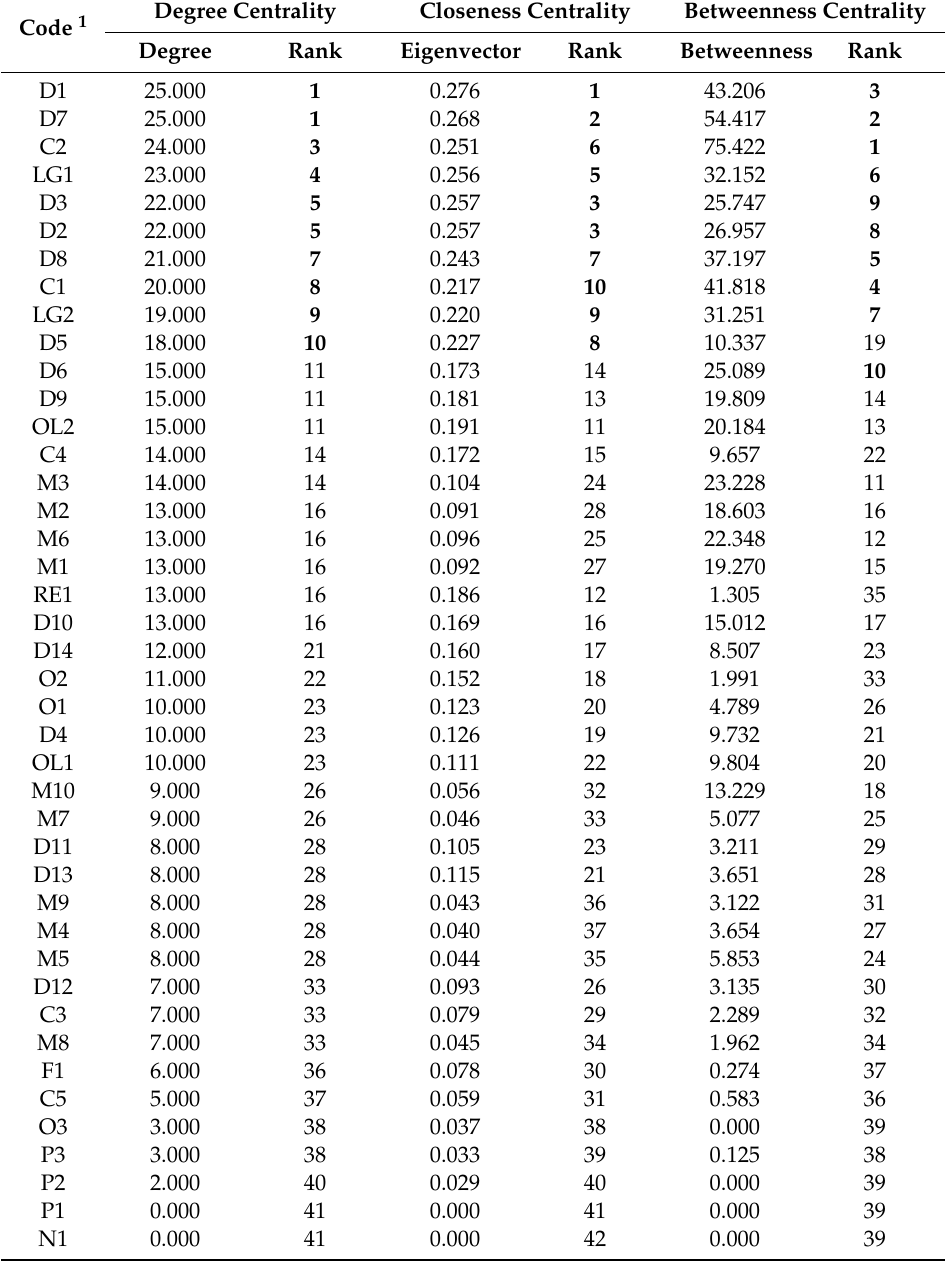
Table 3. The centrality measures of various